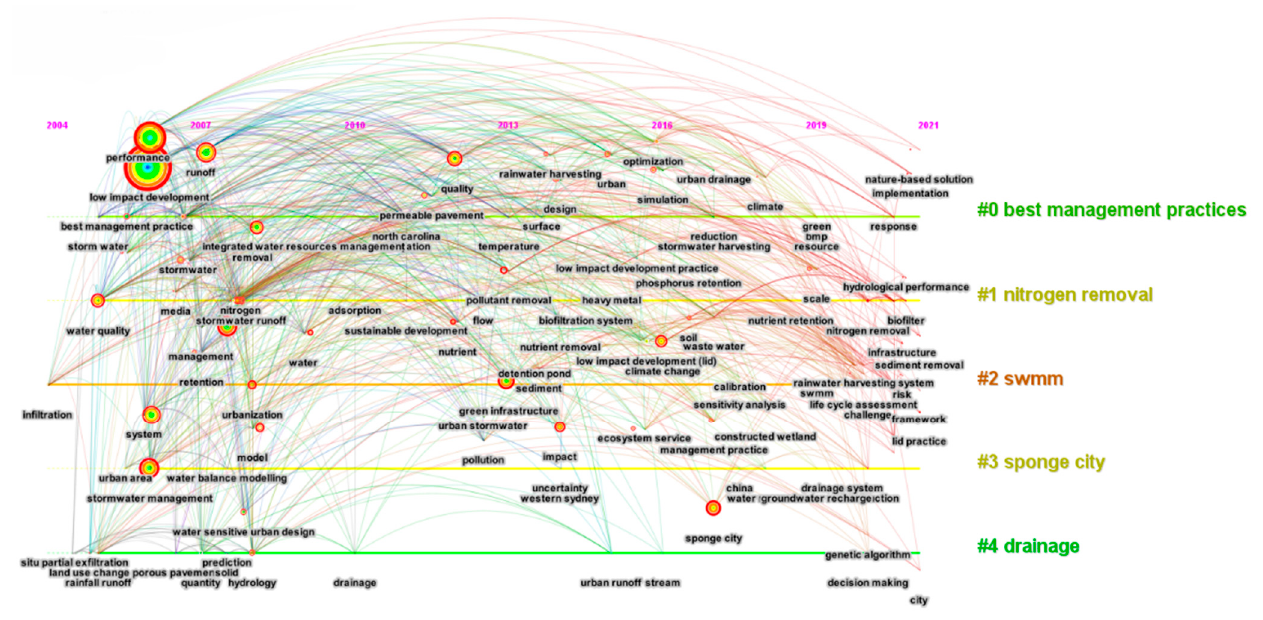
Figure 14. Ecosystem vitality keyword clustering timeline analysis.